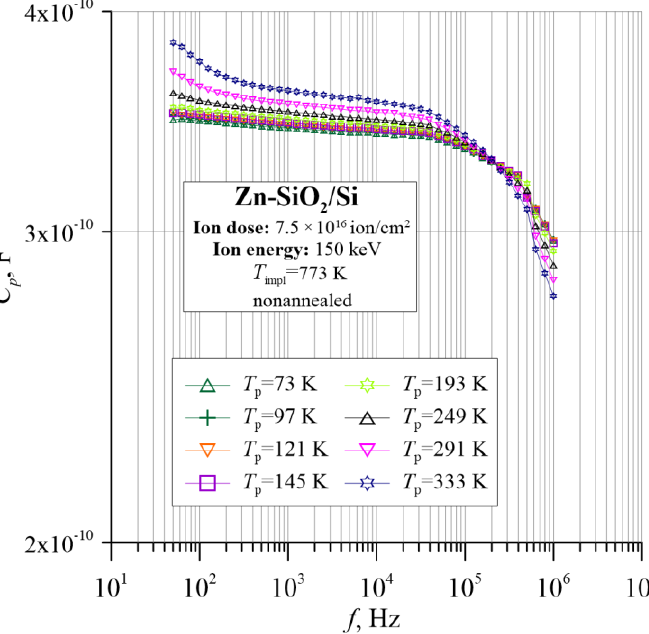
Figure 8. Temperature dependence of the capacitance C p for the Zn-SiO 2 /Si nanocomposite immediately after preparation under “hot” implantation conditions (150 keV, 7.5 × 10 16 ion/cm 2 , T impl = 773 K).